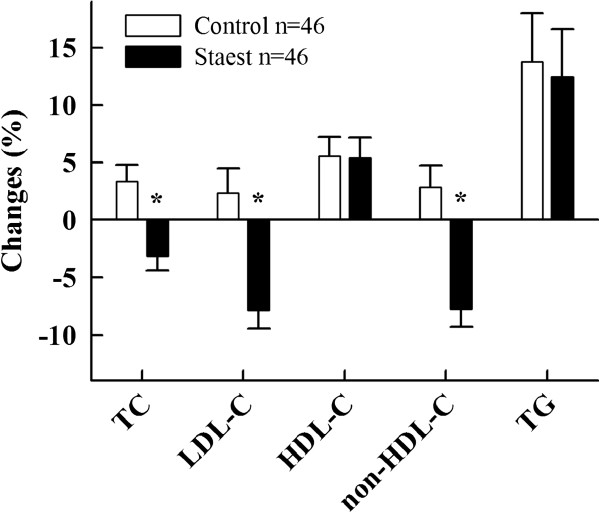
Percent changes in serum total (TC), LDL (LDL-C), HDL (HDL-C), non-HDL cholesterol (non-HDL-C) and serum triglyceride (TG) levels in subjects consuming control and plant stanol ester (staest) spread for six months. * p<0.05 from controls.